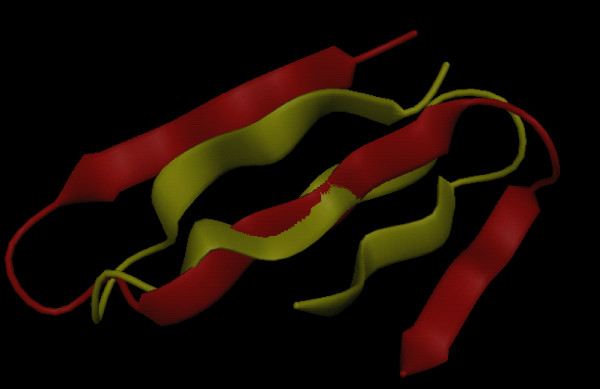
Native (yellow) and  model after all-atom reconstruction and optimization (red) for WW domain (PDB id. 1E0M). The trace of core residues (7–30) is shown.